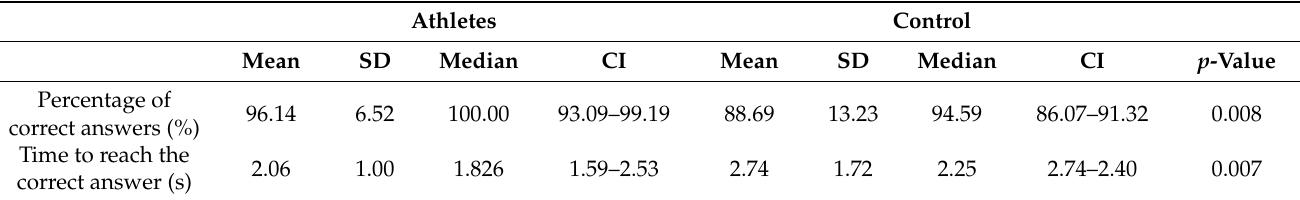
Table 6. “Tic-tac-toe” test results.